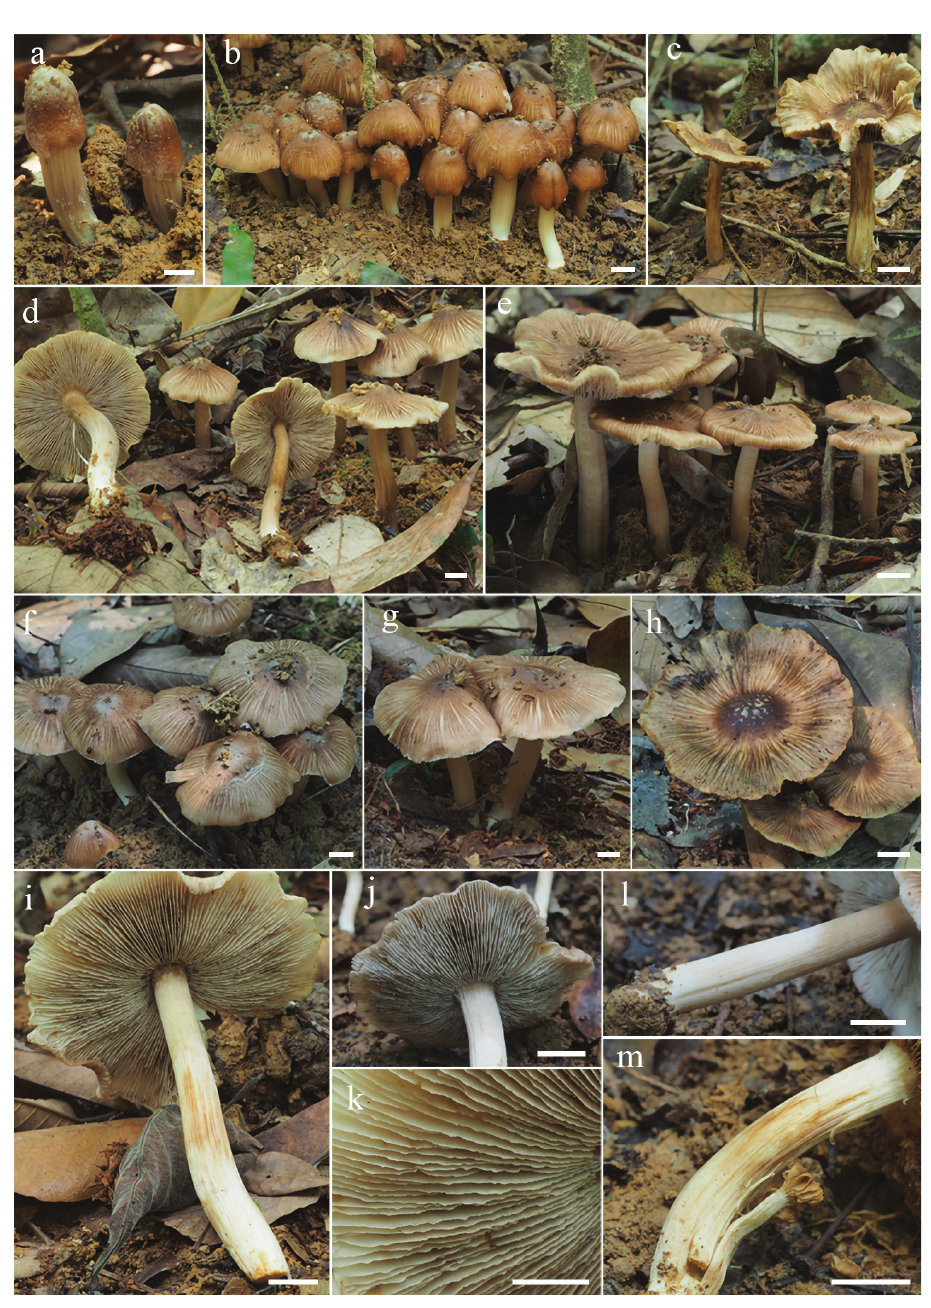
Figure 2. Basidiomata of Inosperma muscarium a–e basidiomata f–h rimose to rimulose pileus i la- mellae j–k lamellae edge l–m stipe surface. a–b, d, f–g, i–m FHMU3162 (holotype) c, e